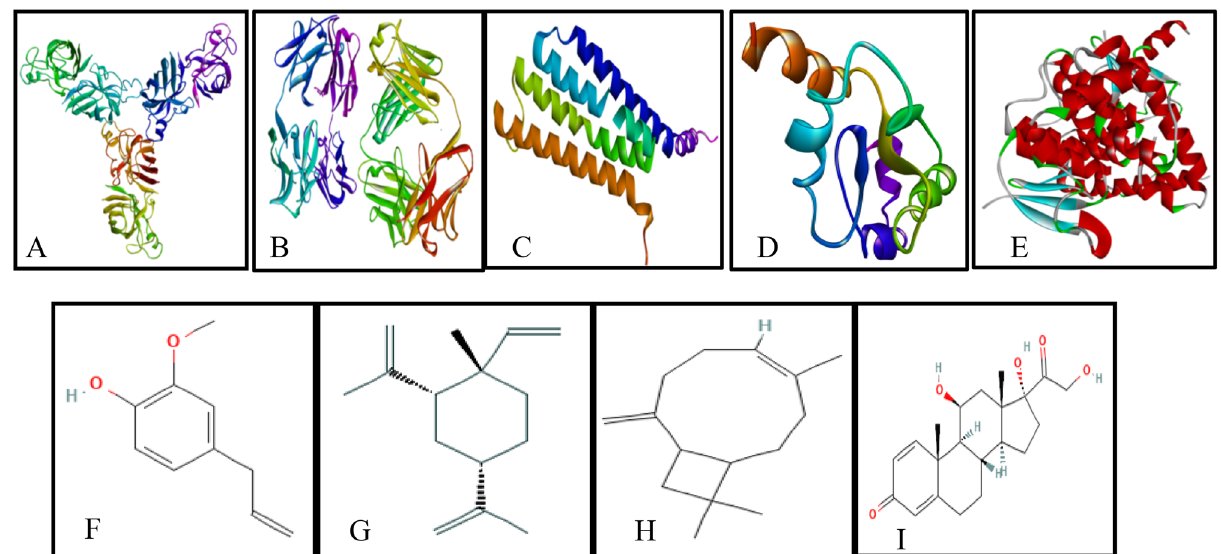
Figure 9. Cartoon representation of the oxidative stress enzymes and structure of major bioactive compounds of OLE extract: ( A ) Superoxide Dismutase; ( B ) Catalase; ( C ) Glutathione Peroxidase; ( D ) Glutathione Reductase; ( E ) Glutathione S Transferase; (F) Eugenol, ( G ) Cyclohexane ( H ) Caryophyllene; ( I ) Prednisolone.